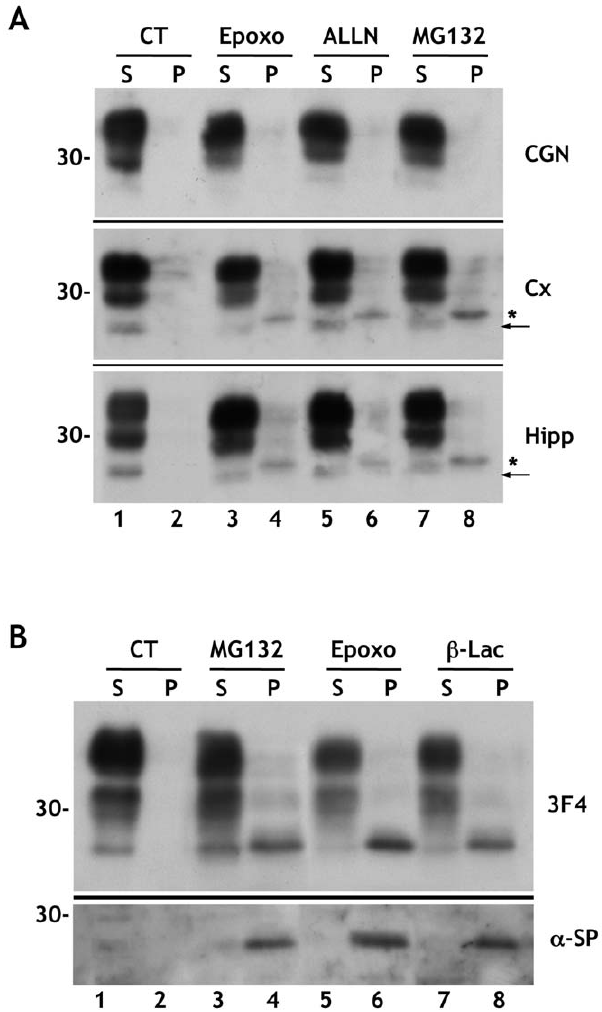
Figure 1. Proteasome inhibitors induce accumulation of insoluble, untranslocated PrP in primary neurons. (A) Cerebellar granule neurons (CGN), cortical (Cx) and hippocampal (Hipp) neurons from C57BL/6J mice were treated for 24h with 5 m M epoxomicin (Epoxo), 100 m M ALLN, 5 m M MG132, or the vehicle alone (CT). Cell lysates were centrifuged at 186,000 x g for 40 min, and PrP in the supernatants (S) and pellets (P) was visualized by immunoblotting with antibody P45-66. The asterisks and arrows indicate bands correspond- ing to untranslocated PrP and mature, unglycosylated PrP, respectively. (B) Cortical neurons from Tg(WT-E1) mice were exposed to 5 m M MG132, epoxomicin (Epoxo), lactacystin b -lactone ( b -Lac) or the vehicle alone (CT). After 24 hours, cells were lysed and centrifuged at 186,000 x g for 40 min. PrP was visualized by immunoblotting with antibody 3F4 (upper panel), and with an antibody against the N-terminal signal peptide ( a -SP) (lower panel). Molecular mass markers are in kilodaltons.